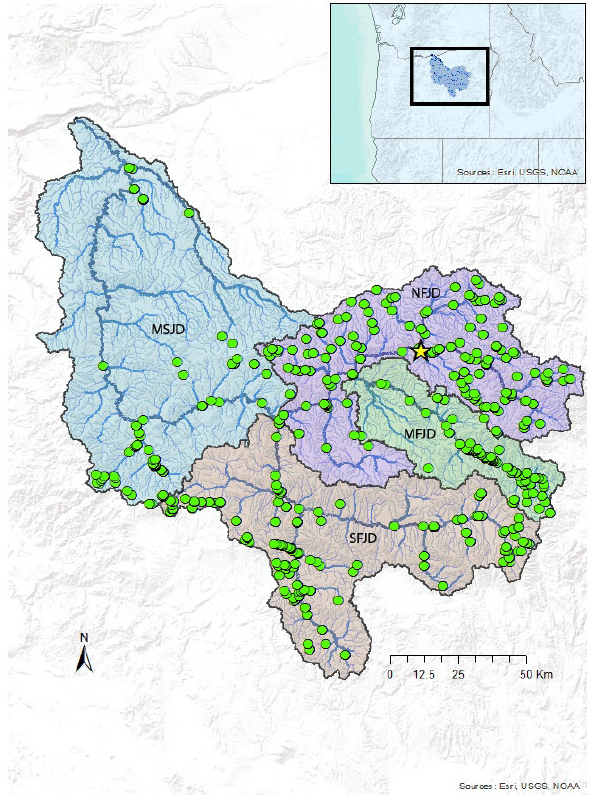
Figure 2. John Day River basin. Green dots represent the location of all temperature logger sites across all years. The yellow star is the site upstream of Camas Creek.